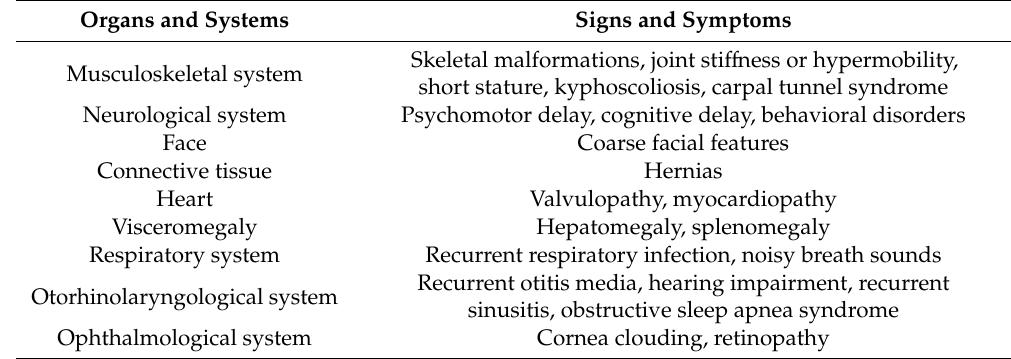
Table 1. Signs and symptoms of mucopolysaccharidoses in di ff erent organs and systems. Organs and